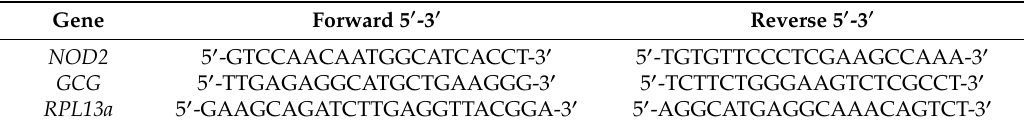
Table 1. Primer sequences used for gene analysis in murine GLUTag